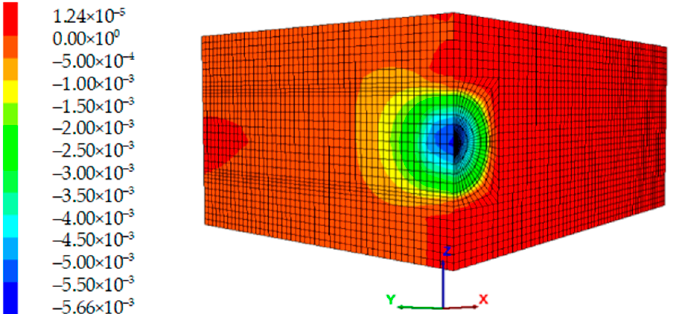
Figure 17. The y-direction displacement contour on the longitudinal section of the tunnel with the optimization scheme (unit: m).